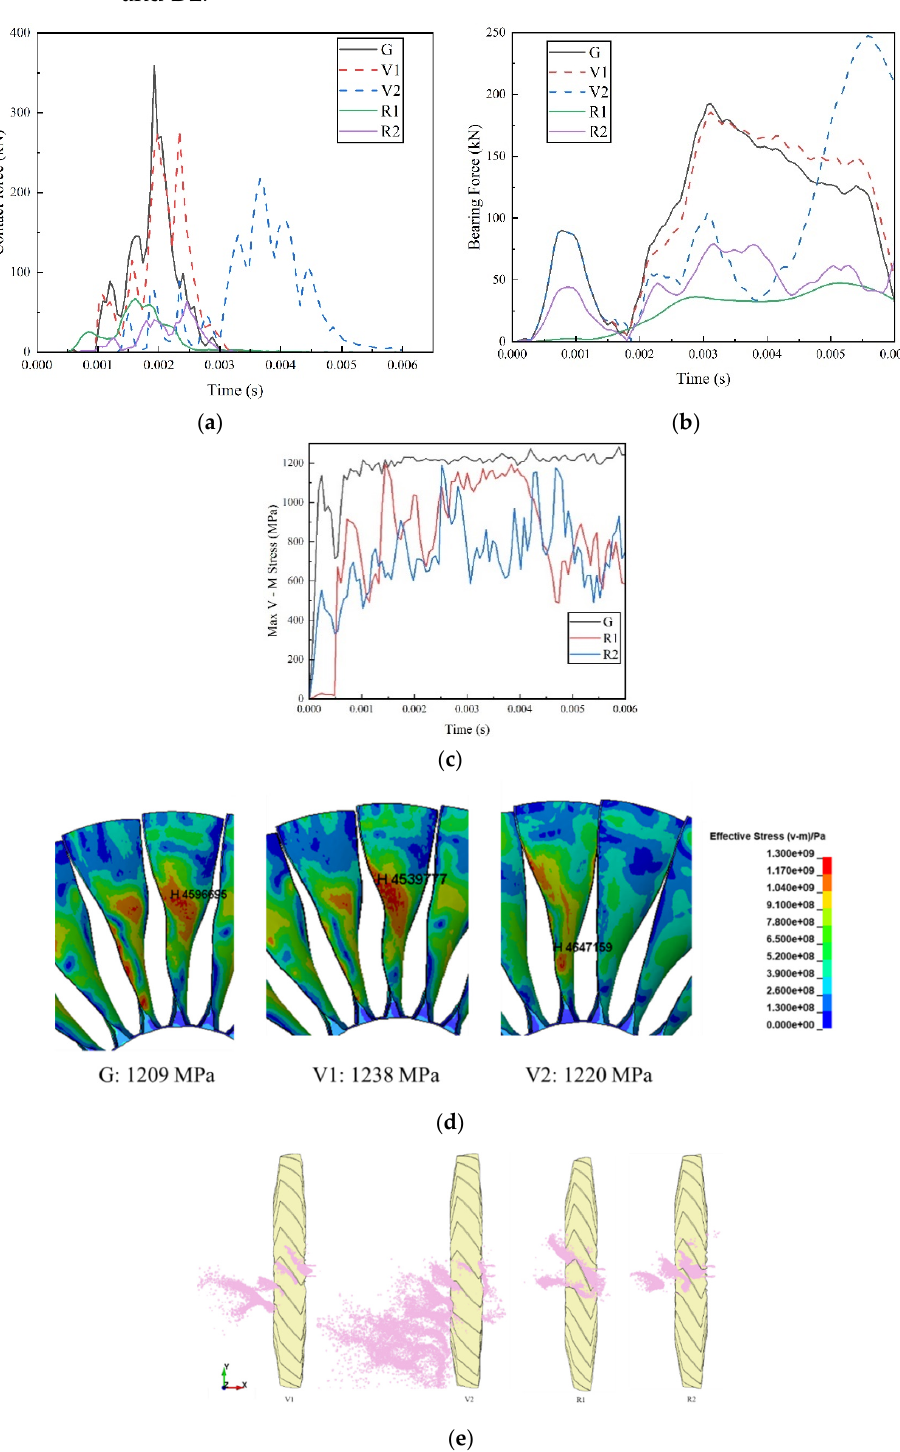
Figure 10. Simulation results of different initial velocities of the bird and rotational speeds of the fan: ( a ) the contact force vs. time; ( b ) the bearing force vs. time; ( c ) the max von-Mises stress on the fan at different rotational speeds; ( d ) the von-Mises stress of different initial velo-cities of the bird; ( e ) bird deformations of different initial velocities of the bird and different rotational speeds of the fan.